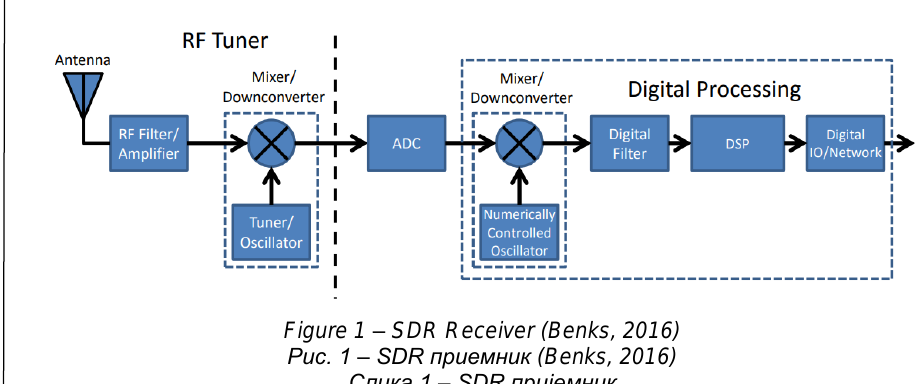
Figure 1 – SDR Receiver (Benks, 2016) Рис. 1 – SDR приемник (Benks, 2016) Слика 1 – SDR